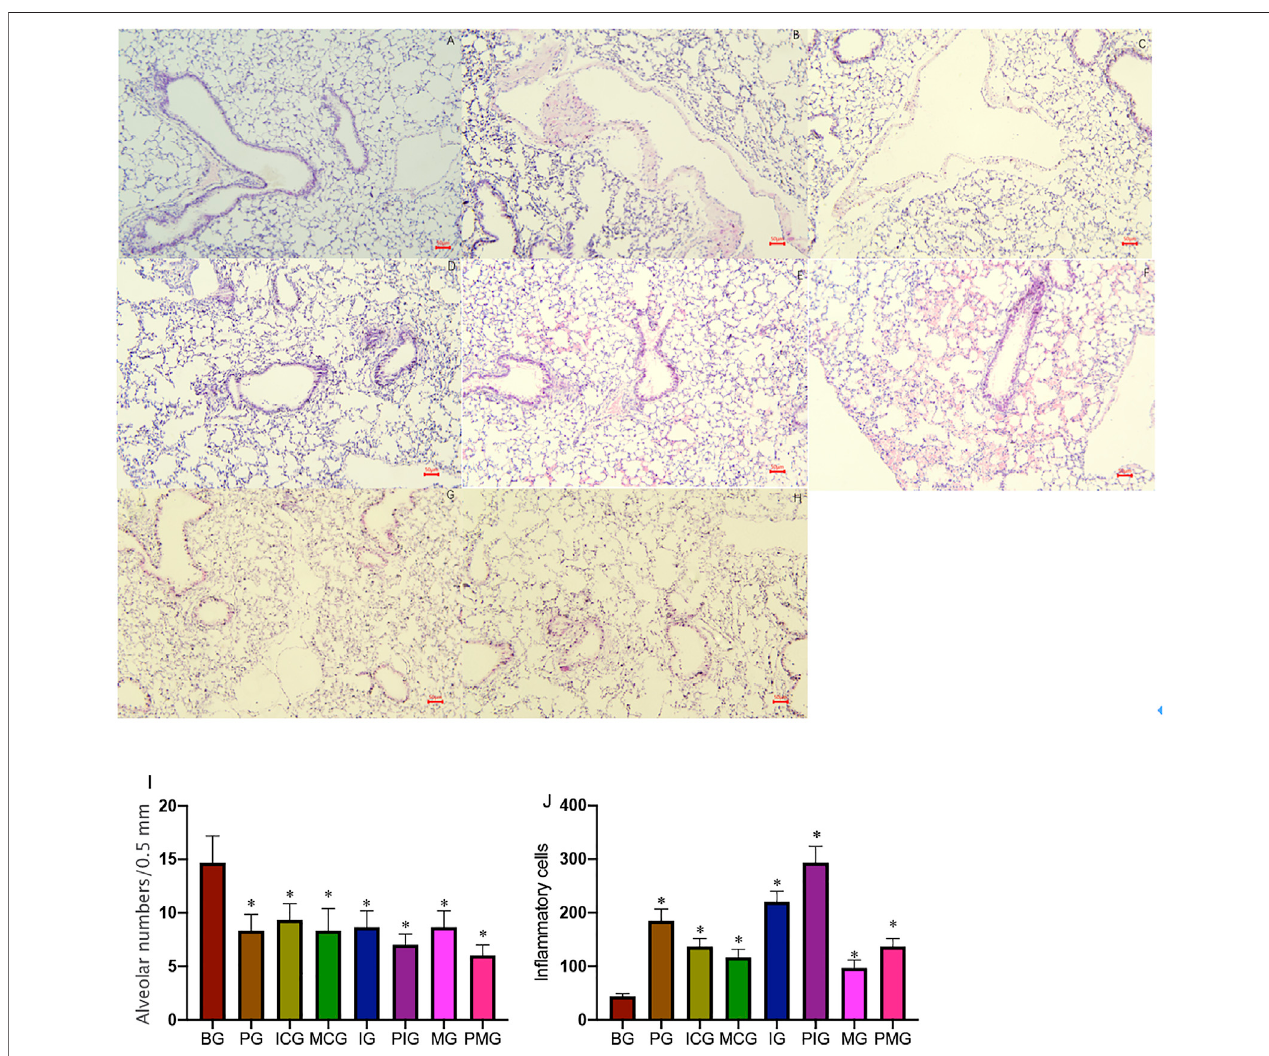
FIGURE 1 | HE staining shows pathological changes of lung tissues in mice after PQ poisoning. (A) , blank control group (BG). (B) , PQ-treated group (PG, a paraquat poisoning model was established via intraperitoneal injection of paraquat). (C) , miR-199 siRNA control group (ICG). (D) , miR-199 mimic control group (MCG). (E) , miR-199 siRNA group (IG). (F) , PQ-treated miR-199 siRNA group (PIG). (G) , miR-199 mimic group (MG). (H) , PQ-treated miR-199 mimic group (PMG). (I) , mean linear intercept (MLI) was used to determine alveolar destruction and altered air space by overlaying a prearranged grid on the image, with set placed lines